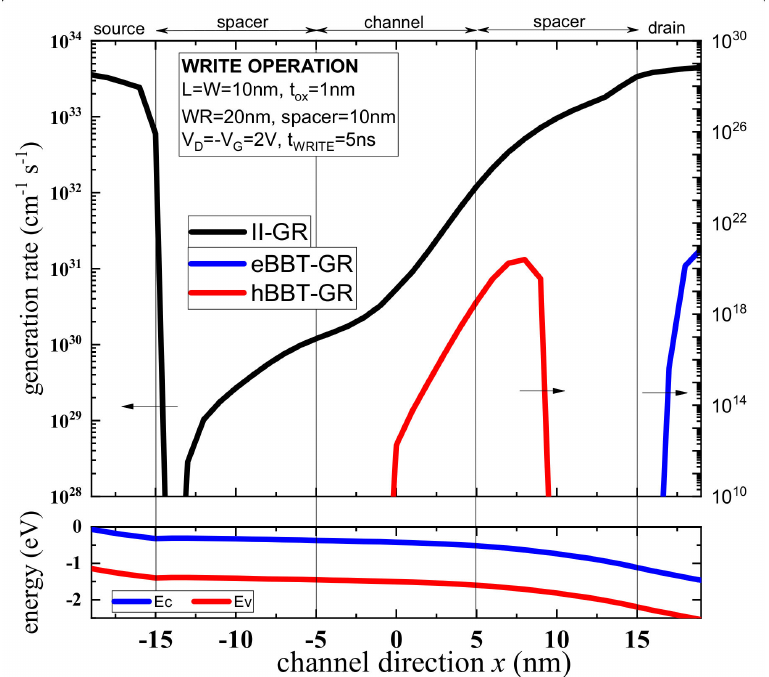
Figure 2. Cutline, along the x channel direction (y = 0), of ( Top ) Impact Ionization and electron/hole Band to Band tunneling (BBT) generation rates and ( Bottom ) conduction and valence bands, at the